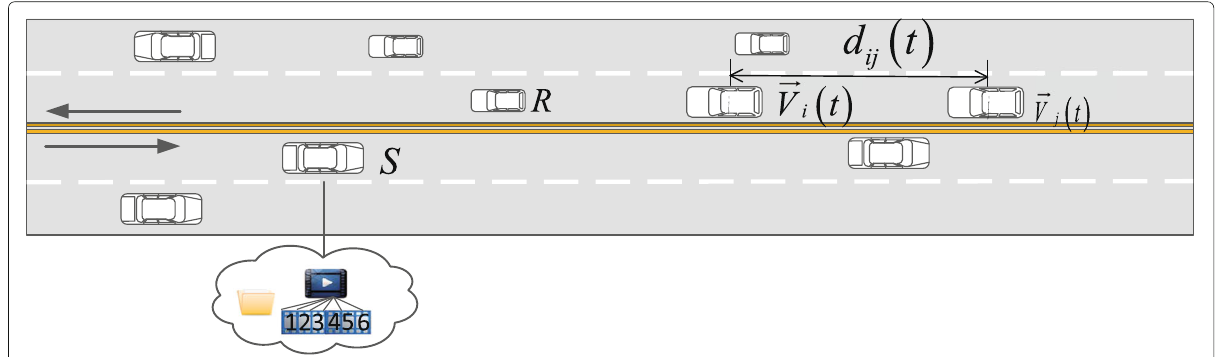
Fig. 1 Real request scenario in